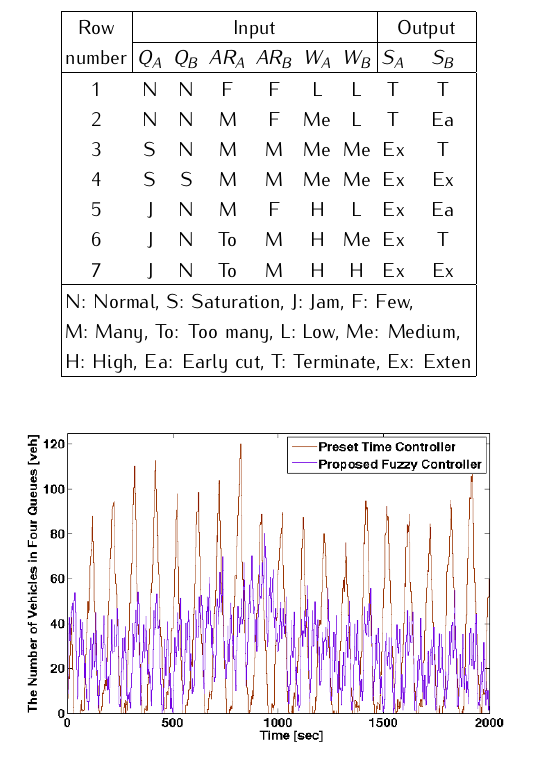
Figure 9. The number of vehicles in four legs in A intersection